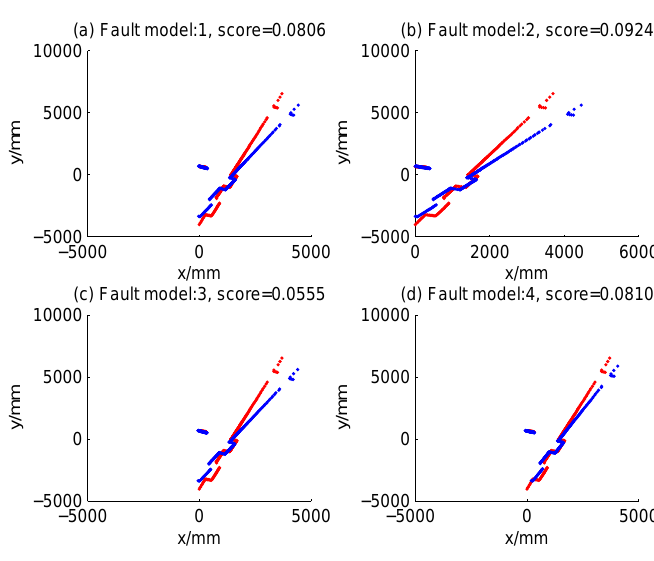
Figure 26. Two sensors are